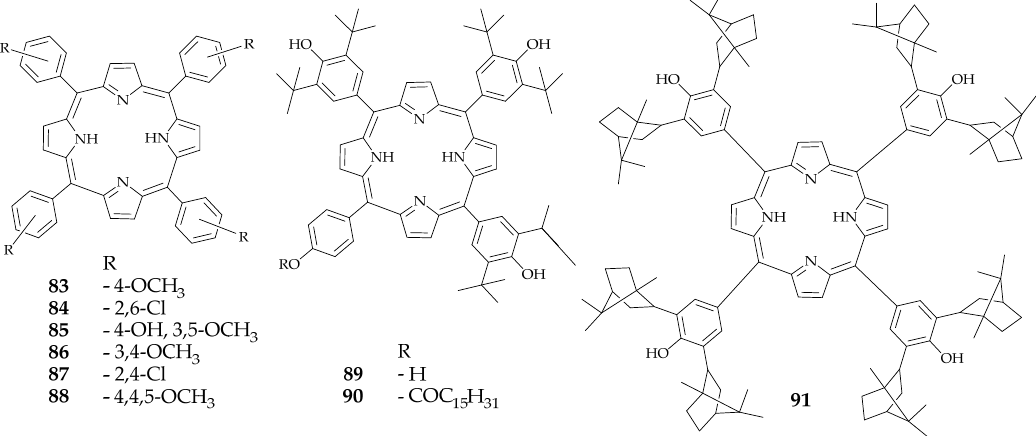
Figure 14. Structures of porphyrin derivatives 83 – 91 .